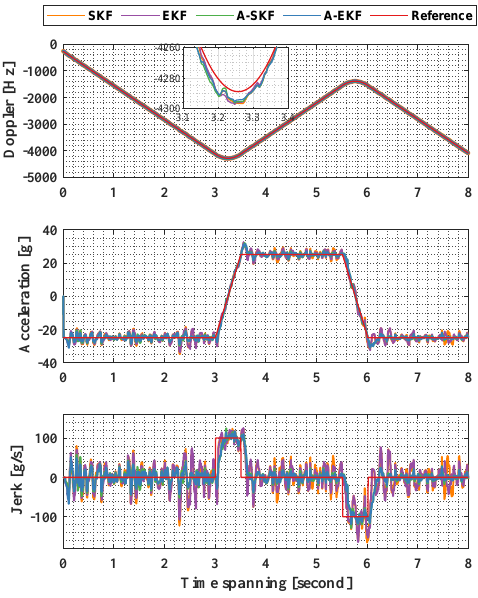
Figure 6. Tracking results when C /N 0 is set to 26 dB-Hz.